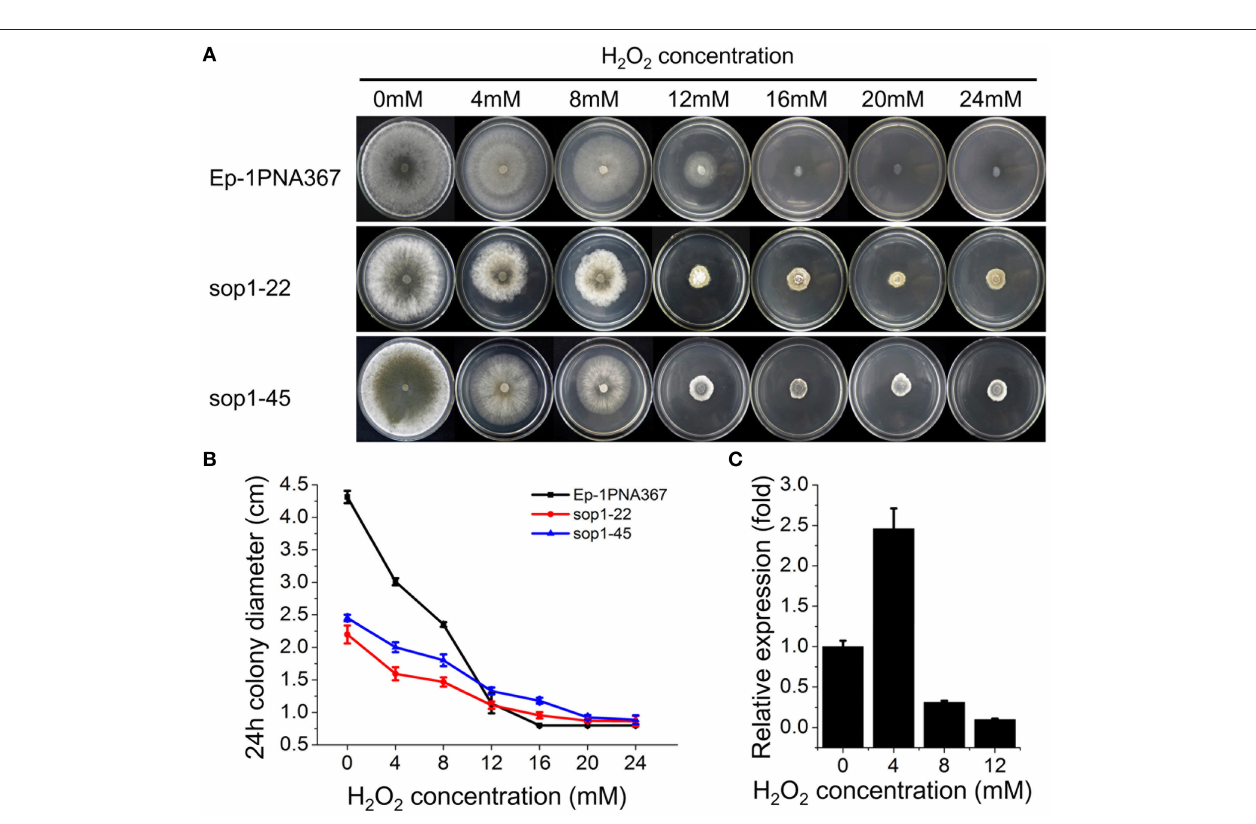
FIGURE 5 | Tolerance of sop1 silenced transformants to oxidative stress. (A) Phenotypes of the sop1 silenced transformants and the wild-type strain on CM supplemented with different concentrations of H 2 O 2 . Photos were taken at 5 dpi. (B) The colony diameter of the sop1 silenced transformants and the wild-type strain on CM supplemented with different concentrations of H 2 O 2 at 24 hpi. (C) The sop1 relative expression levels when the wild-type strain was inoculated on CM with different concentrations of H 2 O 2 as indicated by qRT-PCR analysis. The abundance of cDNA from cultures on CM without H 2 O 2 was assigned a value of 1. The gene expression levels of sop1 were normalized to that of the β -tubulin transcripts from each sample. In all experiments three independent replications were performed, and the values are presented as the mean ± s.d. Bars indicate the standard